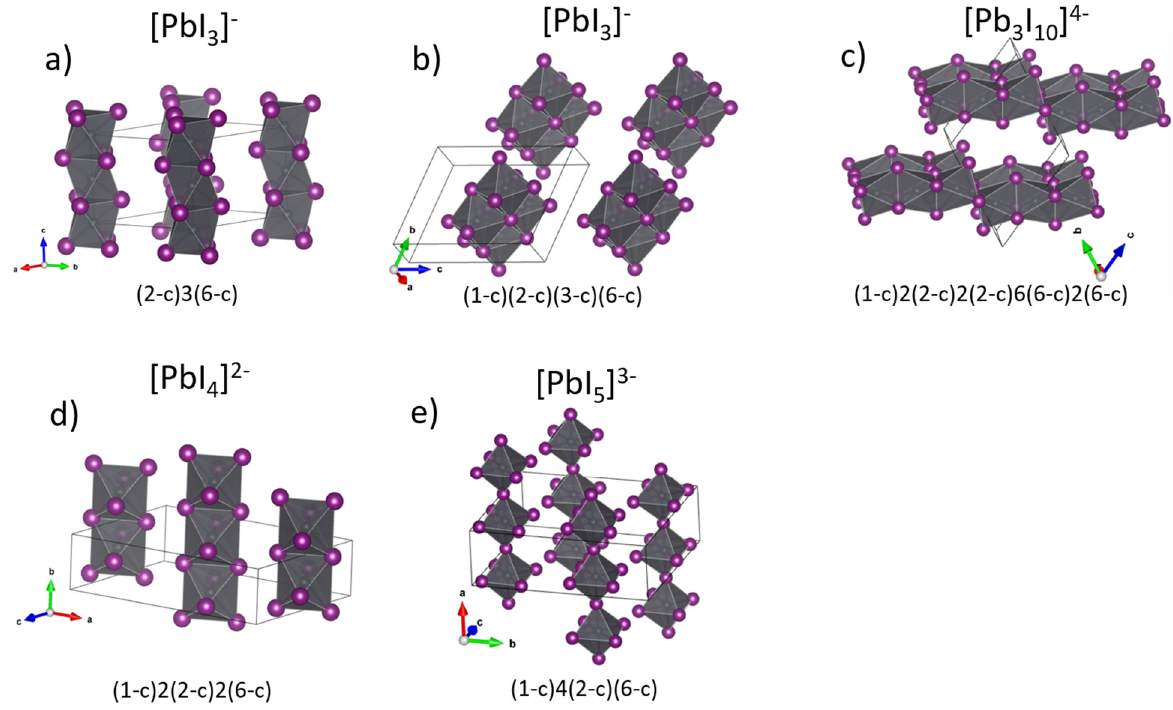
Figure 2. 1D lead-halide hybrid Pb-I subnets with different type of topology: ( a , b ) [PbI 3 ] − , ( c ) [Pb 3 I 10 ] 4 − , ( d ) [PbI 4 ] 2 − , ( e ) [PbI 5 ] 3 − .